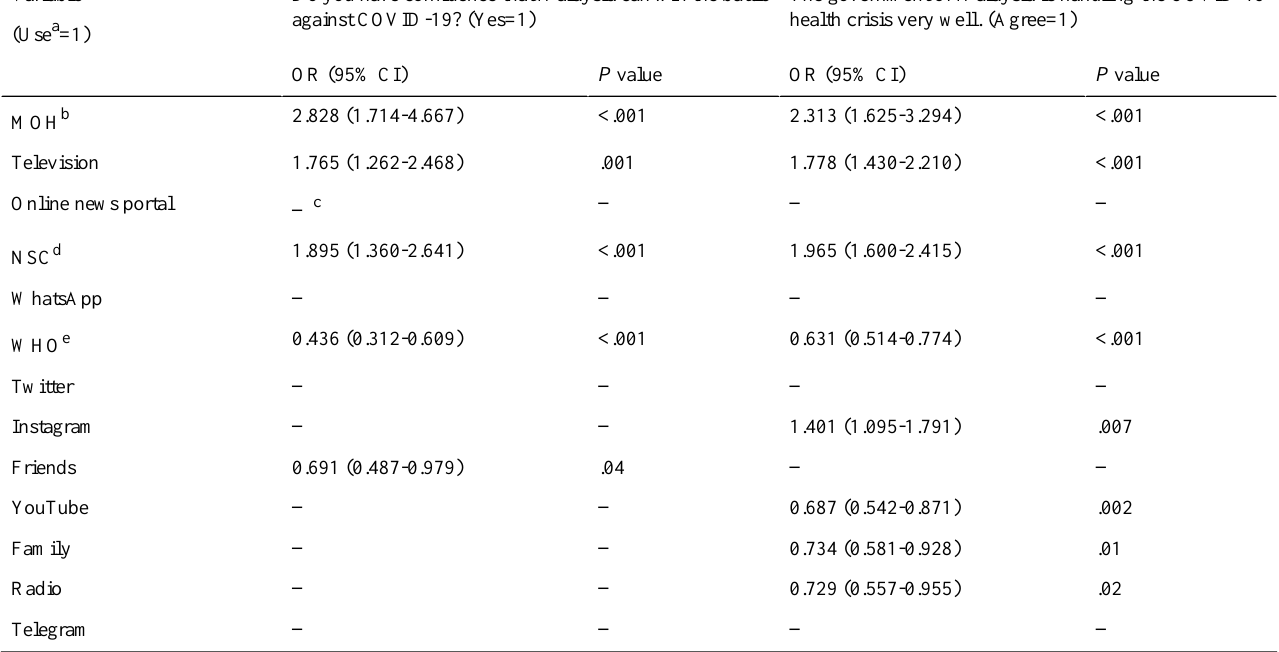
The government of Malaysia is handling the